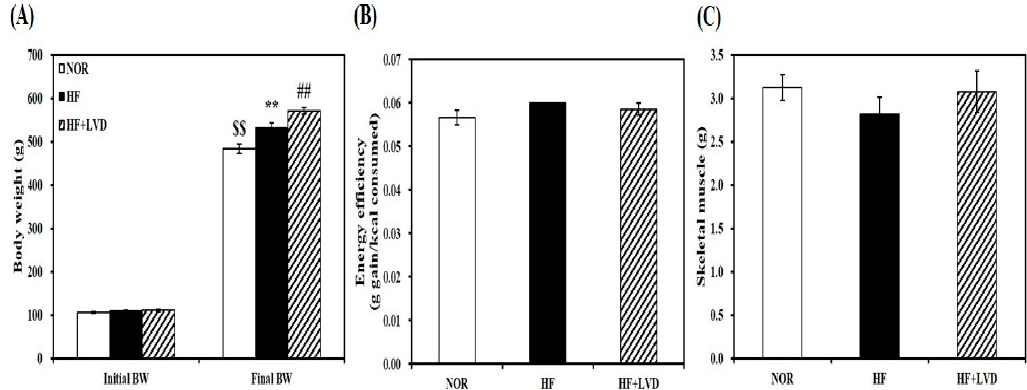
Figure 1. Vitamin D-inadequate diet induces obesity in HF-fed obese rats. Initial and final body weight ( A ), energy efficiency ( B ), and weight of skeletal muscle ( C ). Data is expressed as mean ± SEM ( n = 7–9 per group). $$ p < 0.01 compared to initial body weight. ** p < 0.01 compared to NOR. ## p < 0.01 compared to HF. NOR, 10% fat diet with 1000 IU vitamin D; HF, 45% fat diet with 1000 IU vitamin D; HF + LVD, 45% fat diet containing 25 IU vitamin D.